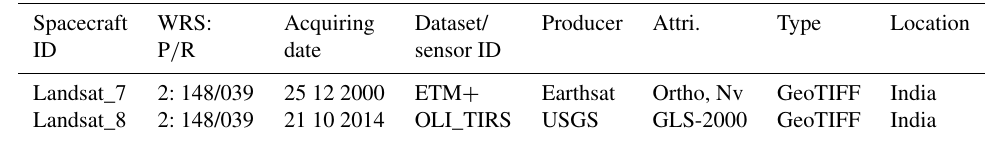
Table 1. Details of the satellite images used for study.